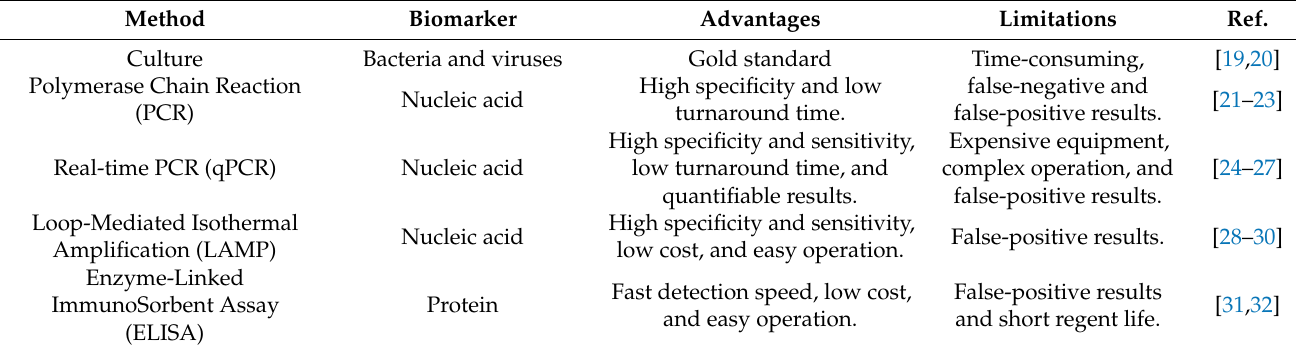
Table 1. Main detection methods for foodborne